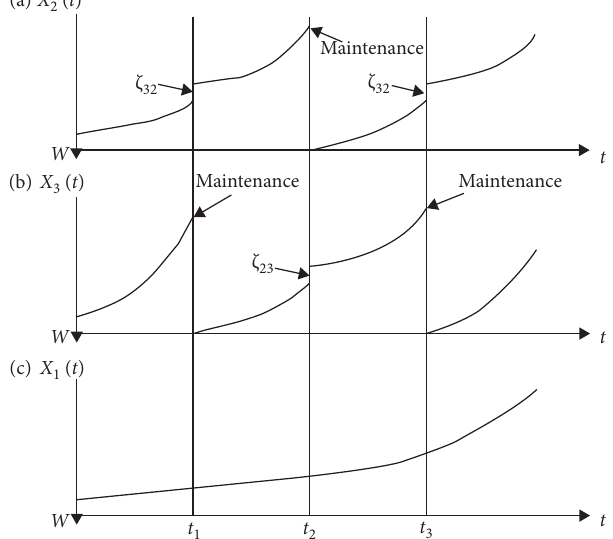
Figure 4: Change graph of the component degradation function considering the impact of disassembly